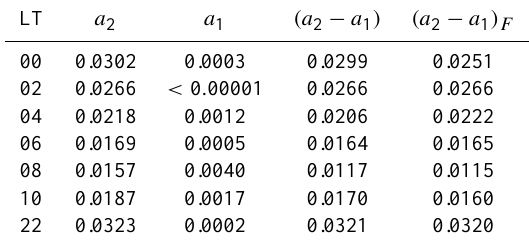
Table 7. Coefficients a 1 and a 2 calculated for various LT